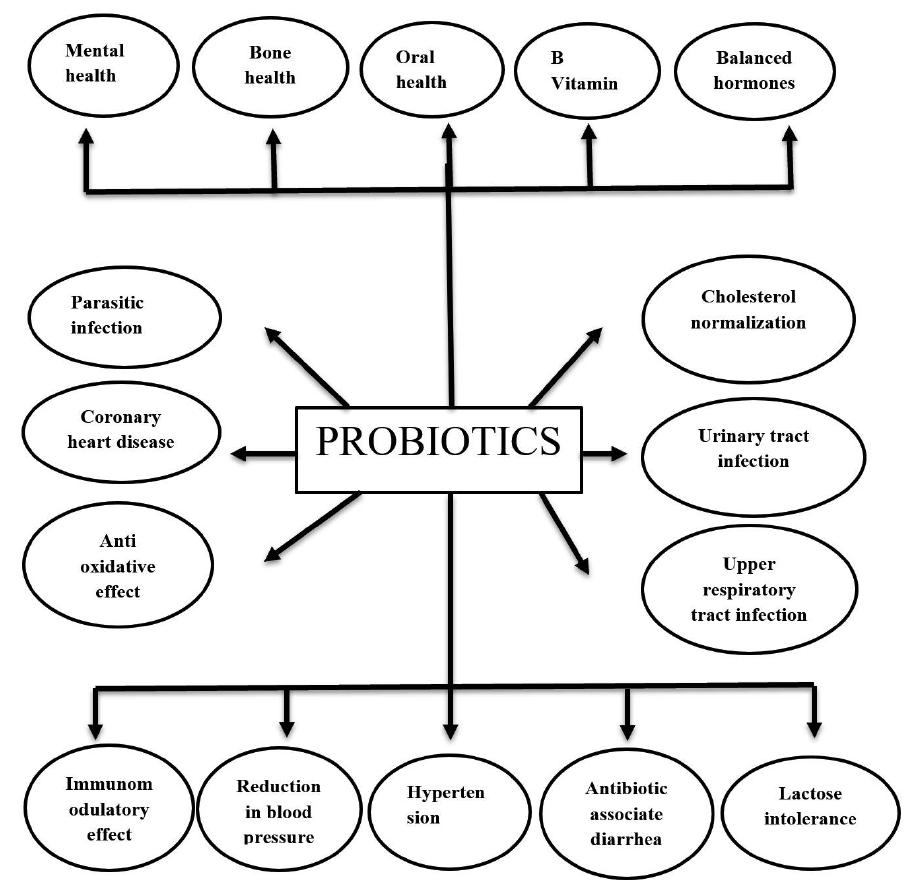
Fig . 1. Health attributes of